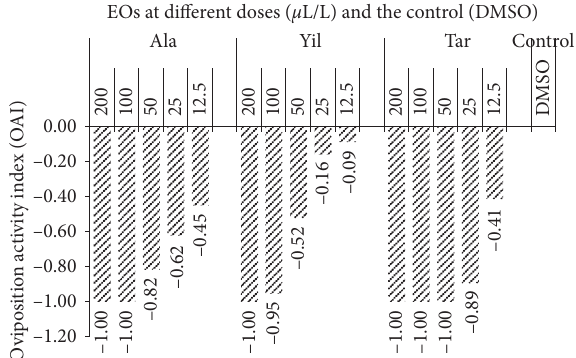
Figure 6: Oviposition activity index (OAI) values of three EOs against A . arabiensis